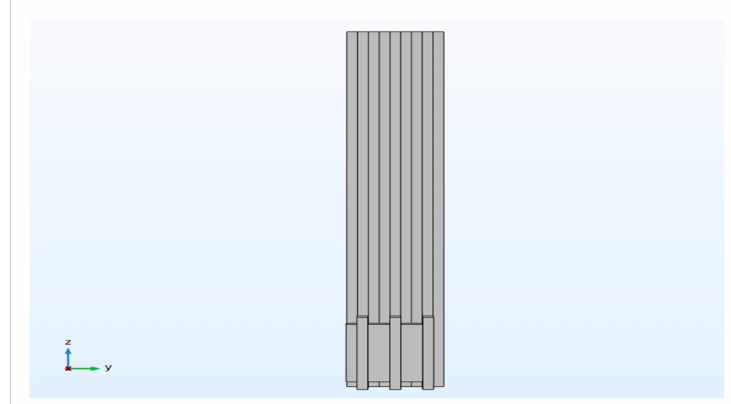
Figure 1. Cross sectional view of a 4.2 Volts / cell, three cell, 70 Ah LiFePO 4 battery stack.